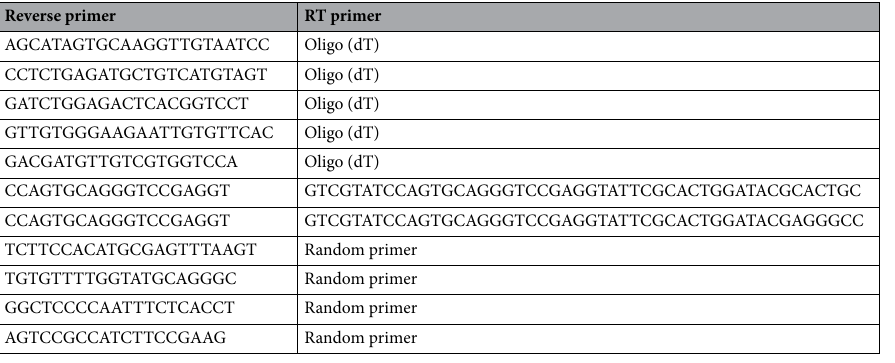
Table 5. Primers used in the